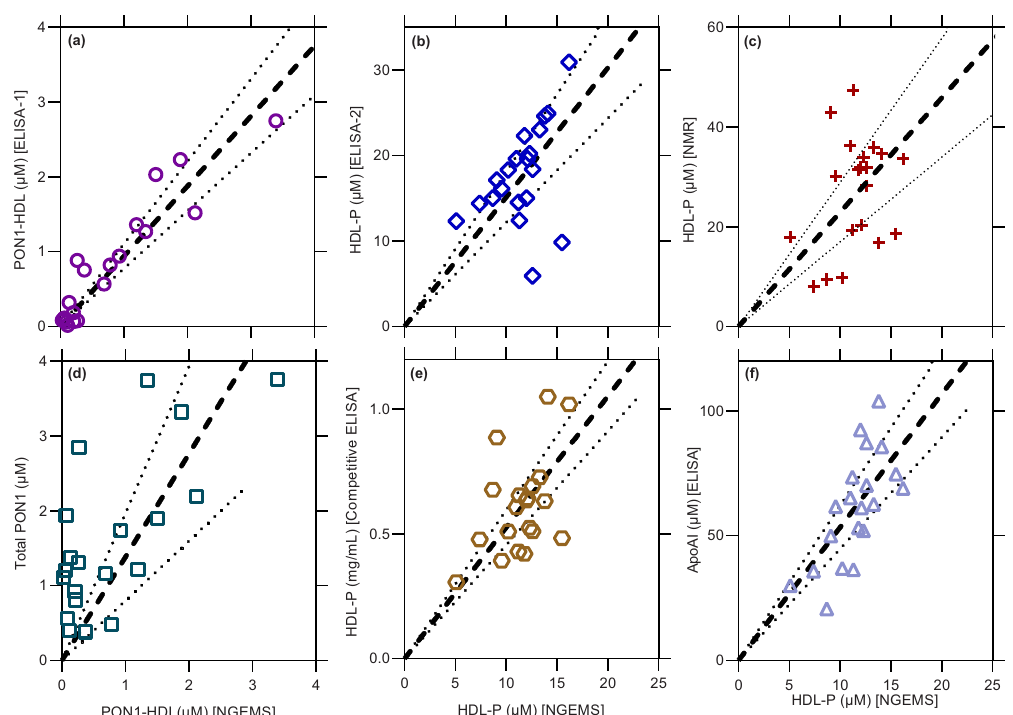
Fig. 6 | Correlation between different measurements from independent plat- forms.a PON1-HDLfromNGEMSvsfromELISA-1. b HDL-PfromNGEMSvsELISA-2. c HDL-P from NGEMS vs 1H-NMR. d Variation of PON1-HDL versus the total PON1. e HDL-PfromNGEMSvscompetitiveELISA. f VariationofHDL-PversustotalApoAI.